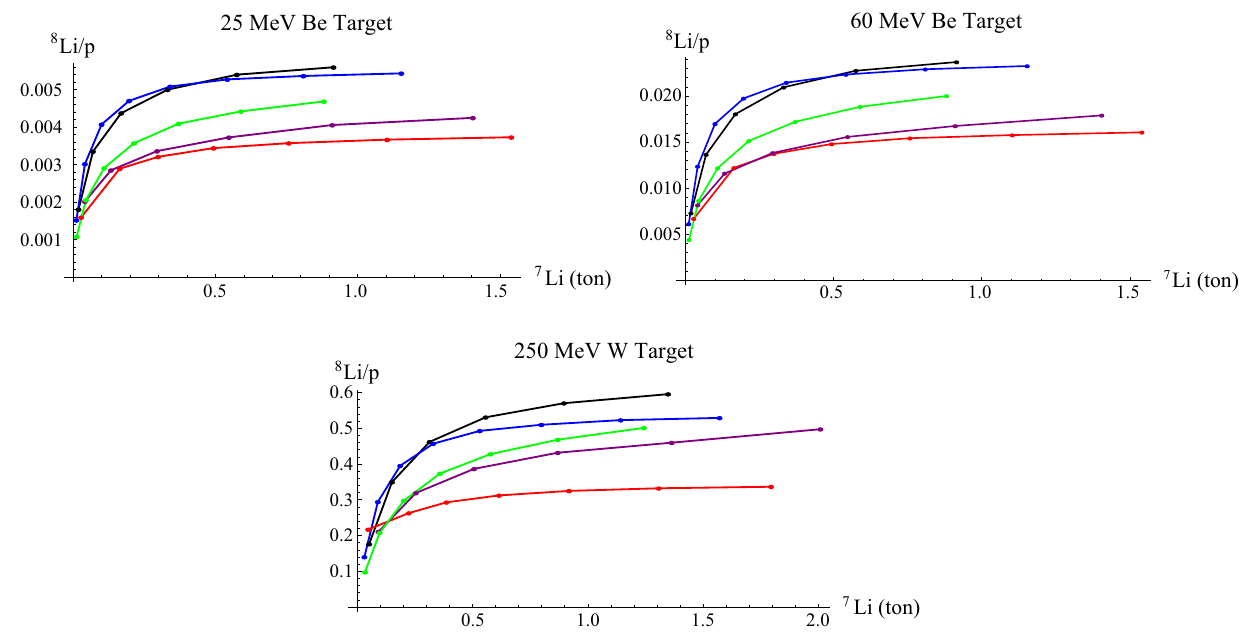
Fig. 6 The 8 Li production given a 25, 60 and 250 MeV proton beam is shown in the three panels as a function of the 7 Li mass. The target is always a cylinder of length 20 cm and radius 10 cm. At 25 and 60 MeV the target is Be. At 250 MeV the target is W and it is surrounded by a